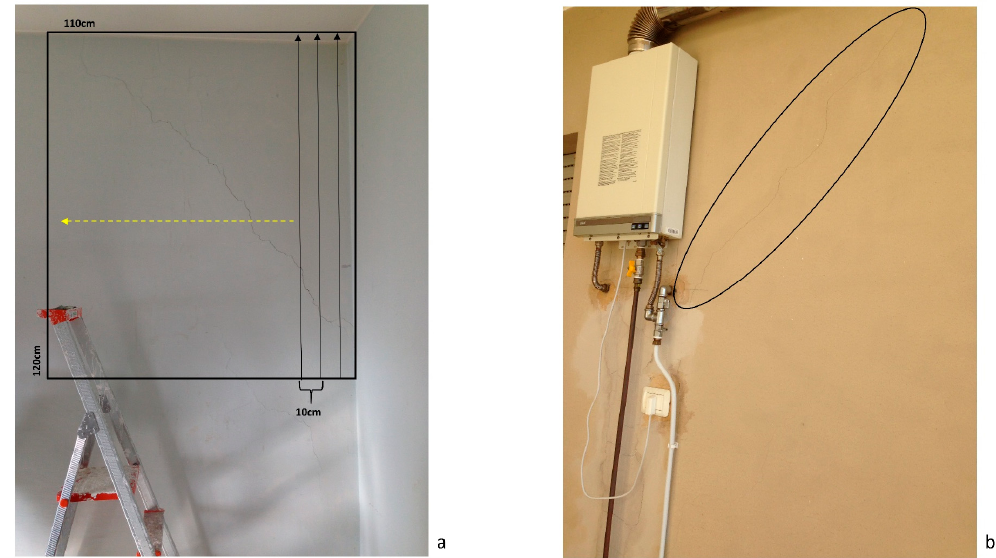
Figure 3. ( a ) The crack in the masonry and the dimension of the one-way grid; ( b ) shows a similar crack in the same wall in the balcony.